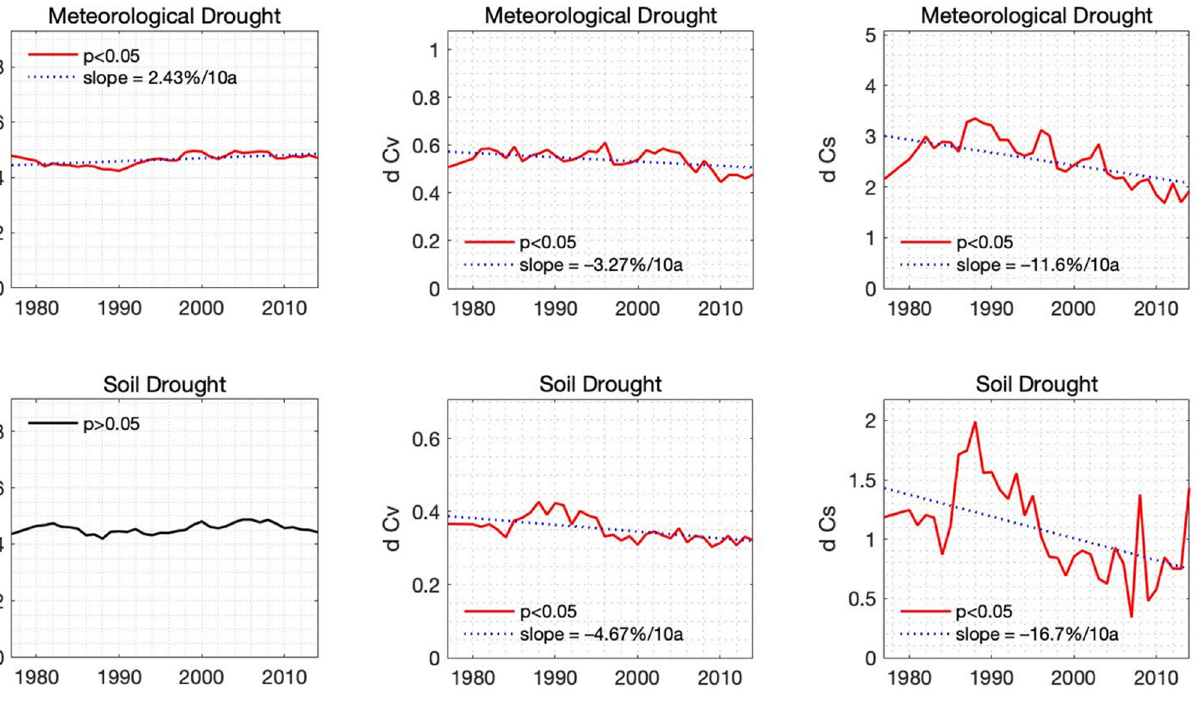
Figure 7. The change in the drought area distribution. a refers to the area ratio as Equation (2).